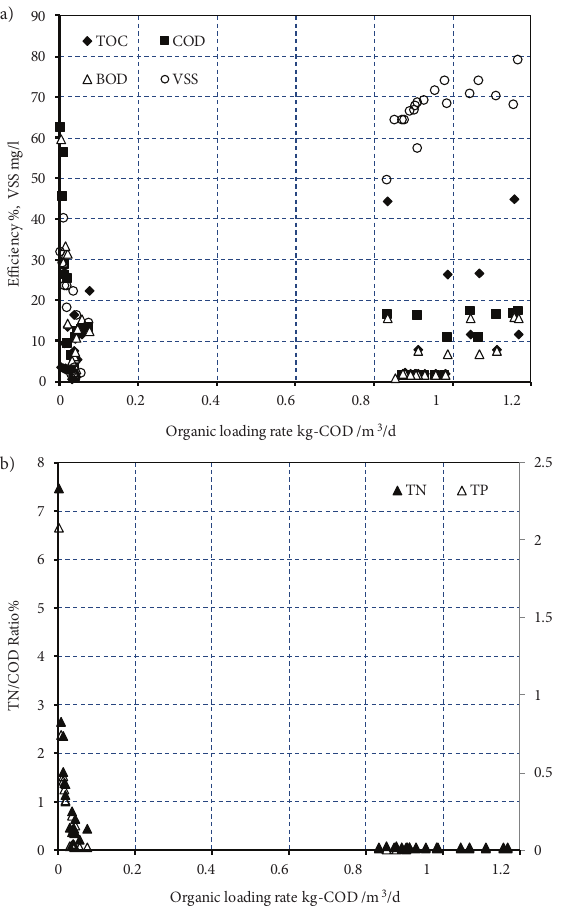
Figure 3. Hybrid biological reactor performance under low flow-high oxygen scenario: a) organics removal efficiency and VSS concentration versus organic loading rate; b) TN/COD, TP/COD, versus organic loading